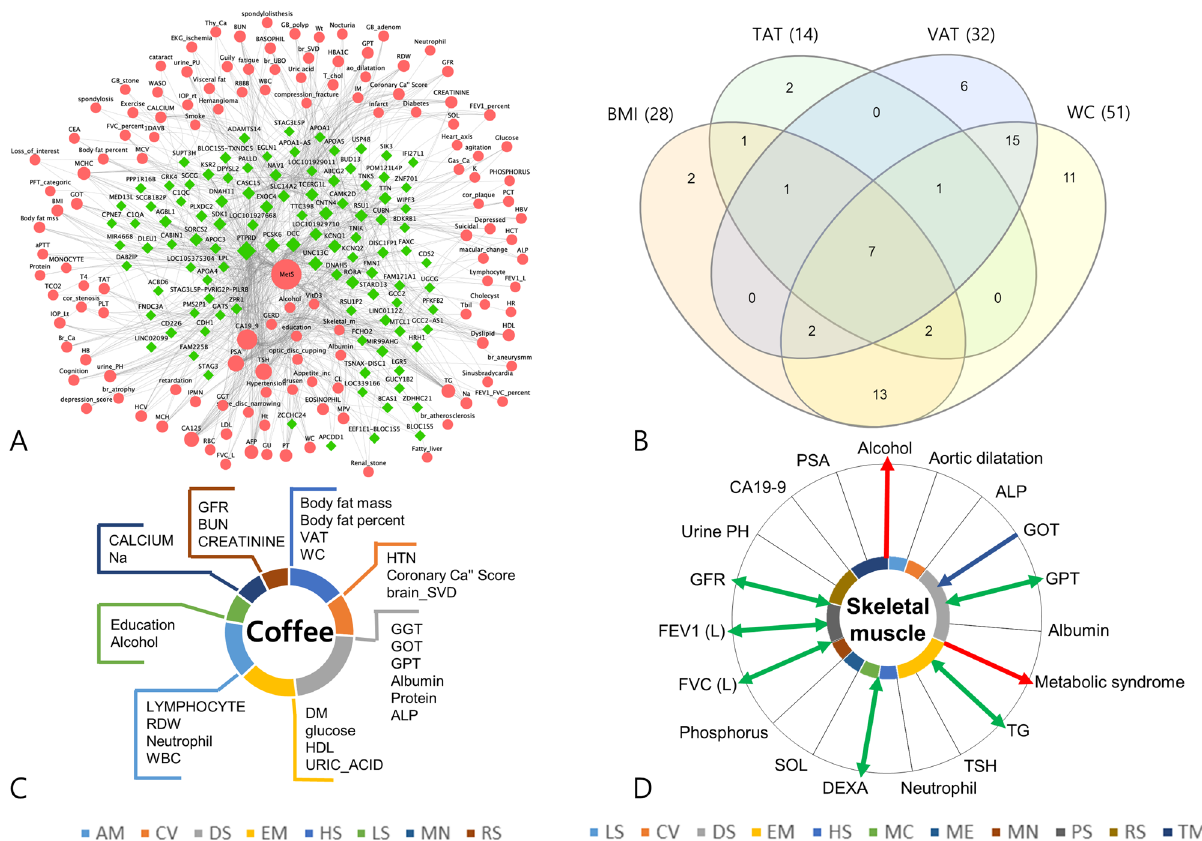
Figure 3. Post-PheWAS analysis. ( A ) Network analysis A network representation of gene-phenotype associations related to metabolic syndrome was constructed from 102 genes associated with metabolic syndrome and 128 phenotypes sharing those genes. Each edge is a phenotype-gene association, with genes for significant loci ( P < 10 –4 ) being annotated by VEP. Node size is proportional to degree, which is the number of connections. Pink nodes correspond to phenotypes and green nodes to genes. ( B ) Relationships among obesity indices We visualized the comparison among the obesity indices such as body mass index (BMI), waist circumference (WC), visceral adipose tissue (VAT) and total adipose tissue (TAT) amount by drawing a the venn-diagram for cross phenotype association of phenotypes or genes. ( C ) Cross‑phenotype mapping Cross- phenotype mappings were generated based on the bipartite phenotype network, in turn constructed from the connections among phenotypes sharing at least one locus. Coffee consumption, which is one of the lifestyle phenotypes, had 31 phenotype degrees in the bipartite phenotype network. ( D ) Causal inference mapping We estimated causal inferences in phenotype pairs based on cross-phenotype associations using Mendelian randomization (MR), and constructed a causal inference map. The direction of the arrow is the causality result from MR (Blue arrows, skeletal muscle mass as outcome; Red arrows, skeletal muscle mass as exposure; Green arrows, bidirectional). Pairs observed in the bipartite phenotype network but insignificant in MR have straight black lines without trends in the Korean and Japanese populations, but manifested relatively high heritability in Koreans relative to the UK population. Network analysis. Using cross-phenotype association information, we constructed phenotype-phenotype and phenotype-genotype networks. First, a network representation of gene-phenotype associations related to metabolic syndrome was constructed (Fig. 3A). 132 genes associated with metabolic syndrome and 128 phenotypes sharing 102 genes with metabolic syndrome were used to construct the network. In the metabolic syndrome sub-network, five genes had high degrees of connection and could be considered hub genes: PTPRD, DCC Netrin 1 Receptor (DCC), Proprotein Convertase Subtilisin/kexin Type 6 (PCSK6), Unc-13 Homolog C (UNC13C), and Contactin 4 (CNTN4). The phenotypes in this network comprised: of cardiovascular diseases, of metabolic diseases, used as markers for obesity, and other various disease. The phenotype nodes included tri- glyceride (TG), HDL cholesterol (HDL), hypertension, diabetes, and waist circumference (WC). These results give a genetic rationale for the definition of metabolic syndrome in the PheWAS perspective.